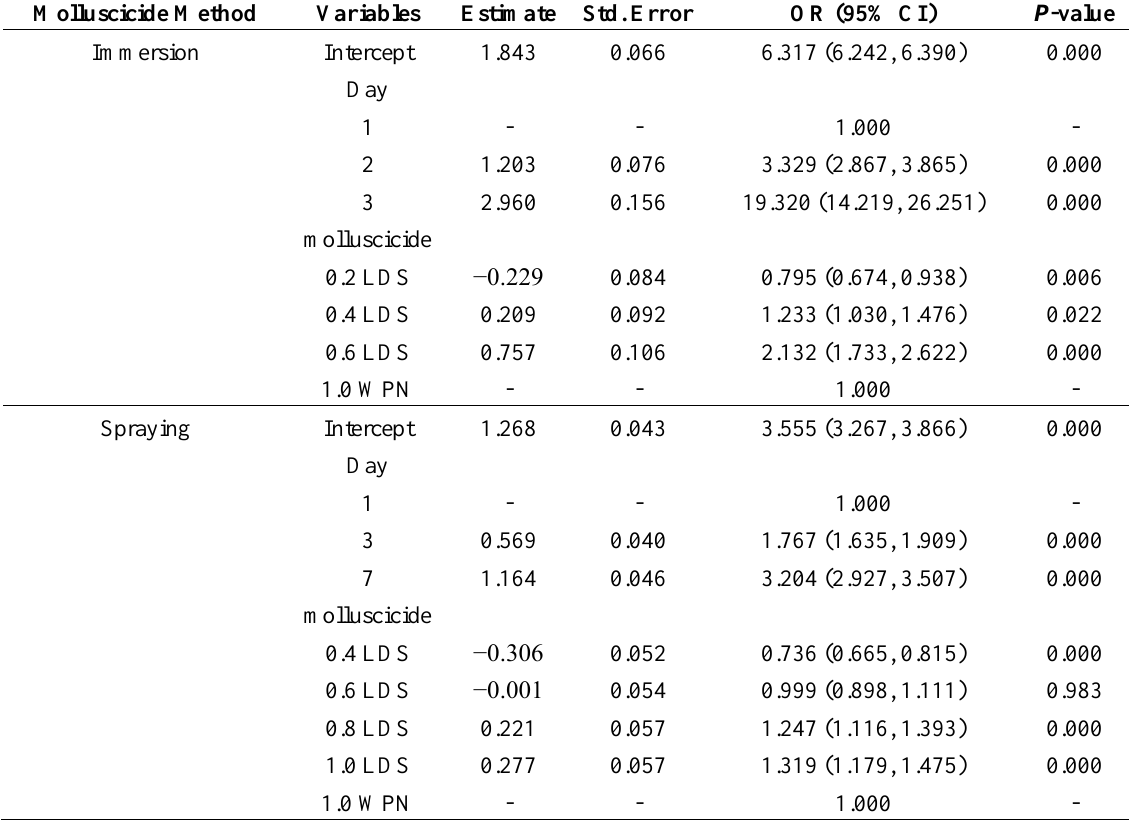
Table 3. Analyzing the influence factors of the mortality of snails in different molluscicide methods by binary logistic